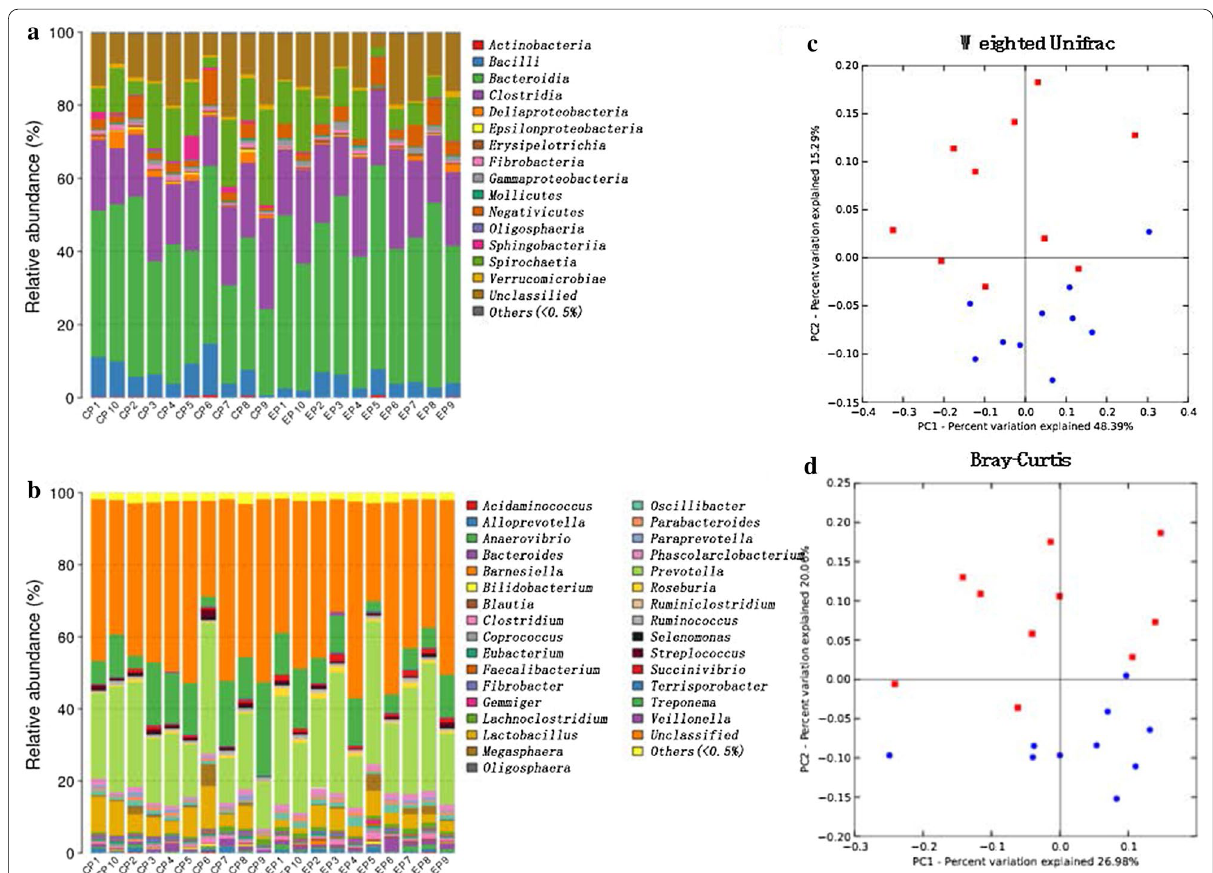
Fig. 2 Microbial community compositions in the intestines in the CP and EP groups. Taxonomic composition at the class ( a ) and genus ( b ) levels. Only classes and genera with an abundance > 0.5% in any group were plotted. PCoA of microbiota based on weighted UniFrac ( c ) and Bray‑Curtis ( d ) distances. Red dots represent the distribution of CP group samples, while blue dots represent the distribution of EP group